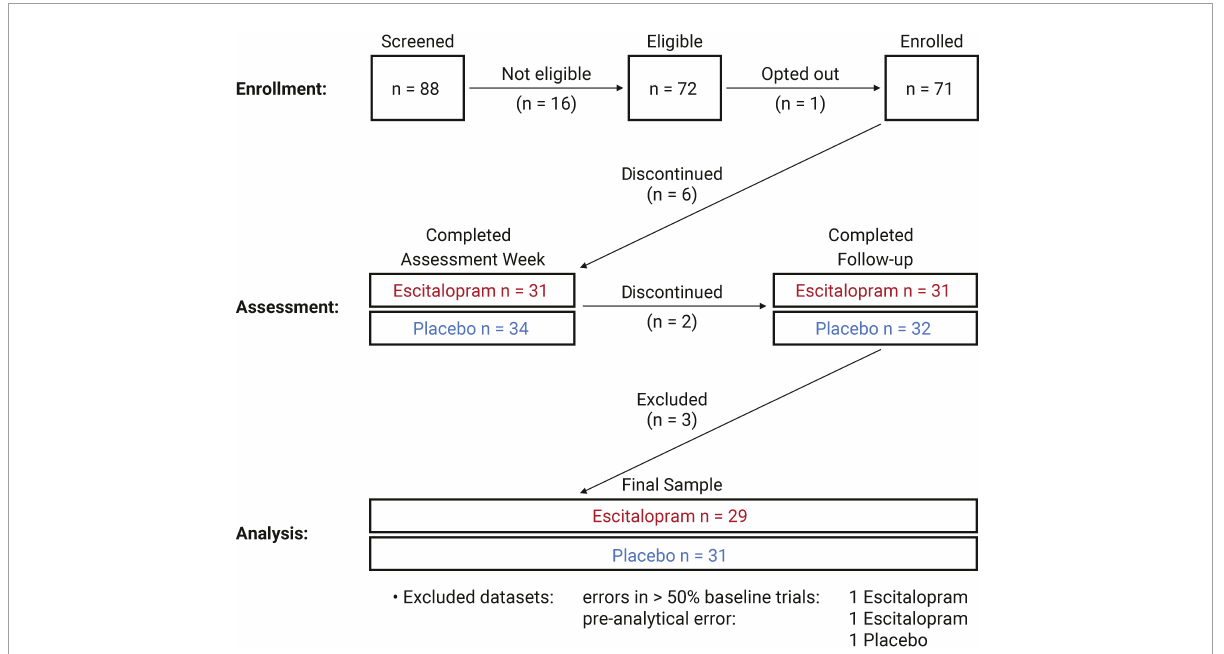
FIGURE1 Inclusions and exclusions: The figure depicts the number of participants included in each step of enrollment, assessment, and analysis. Due to self-reported side effects, 6 participants voluntarily discontinued participation during the assessment week (placebo = 2, escitalopram = 4). Two participants did not return for the follow-up assessment. Three participants (placebo = 1, escitalopram = 2) were excluded following implementation of quality control